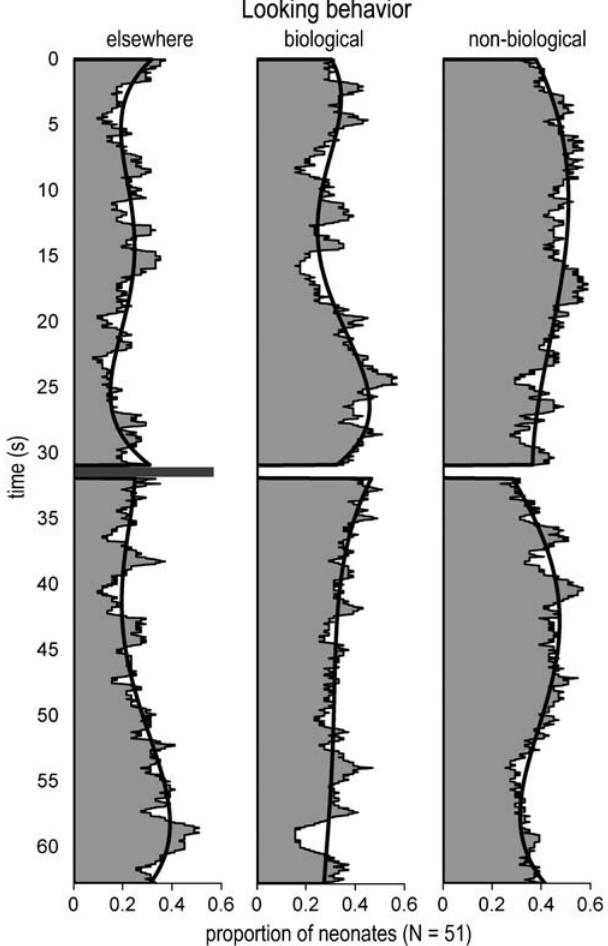
Figure 2. Frequency of the three behaviors in the neonates sample as a function of time. It provides an estimate of the time-varying probability of observing a given behavior. The gray bar corresponds to the 1 s pause. The data were fitted with a fourth order polynomial to figure out the global trend.